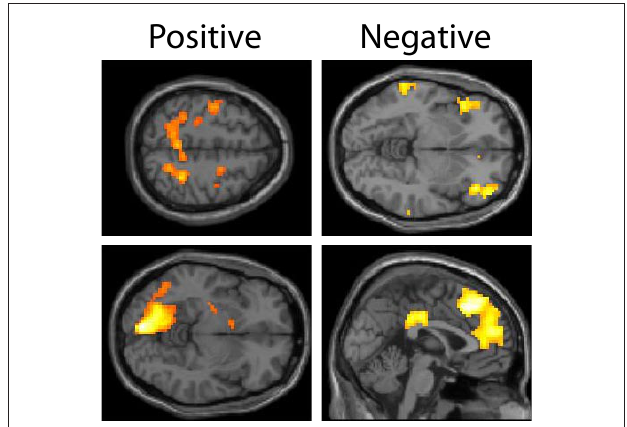
FIguRe 4 | Lottery × eV response. Regions whose BOLD activity gamble responded in an increasing manner to less negative outcomes are shown in the left column, and regions whose BOLD activity responded increasingly to more negative outcomes are shown in the right column. Regions shown in the positive contrast include the frontal eye fields, intraparietal sulcus, left visual area, and ventral striatum. Regions shown in the negative contrast included the left OFC, DMPFC, genual ACC, and posterior cingulate